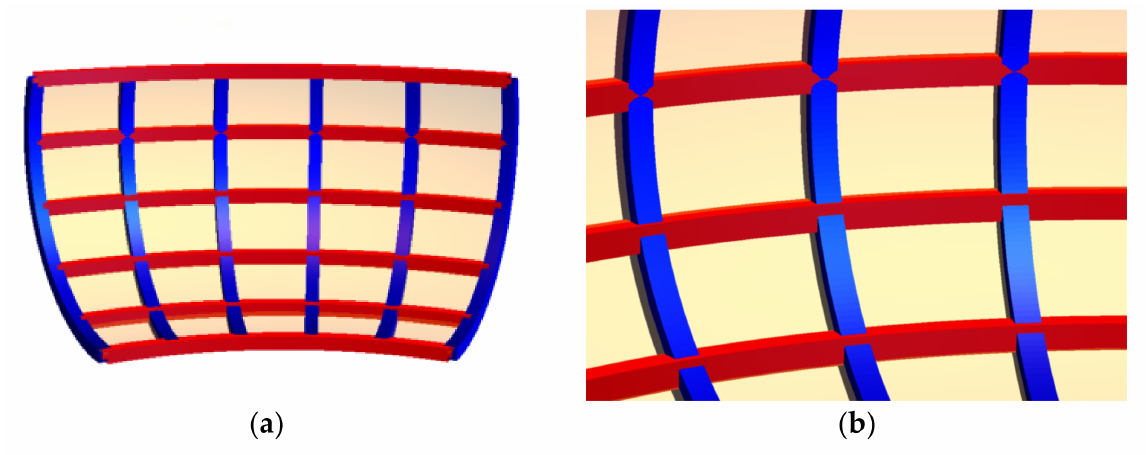
Figure 6. Visualization of LoCs on the LA surface ( α = − 1 ) : ( a ) Curvature lines on LA surface; ( b ) Close up view of ( a ).